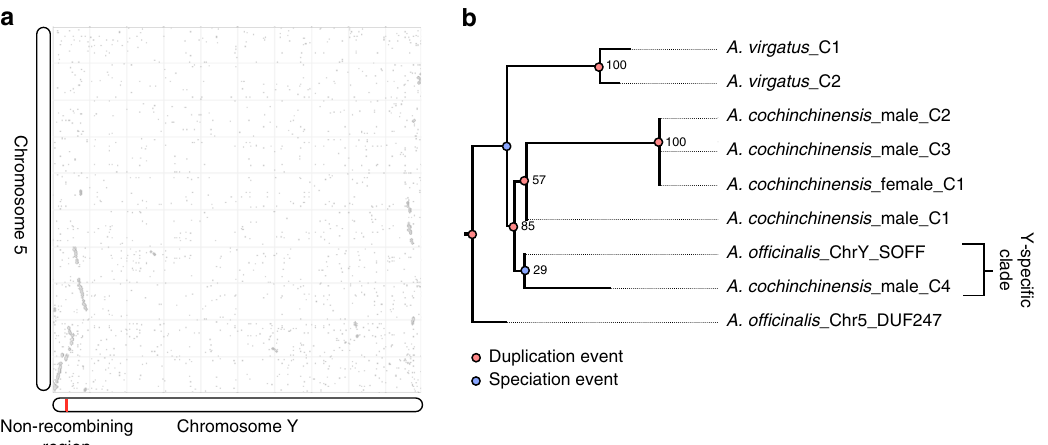
Fig. 4 Polyploidy and the evolution of sex determination genes. a Synteny dotplot between chromosome Y and chromosome 5. b Gene tree of homologous SOFF gene contigs identi fi ed in hermaphroditic A. virgatus and a male and female accession of A. cochinchinensis . The gene and species tree were manually reconciled to identify speciation nodes versus gene duplication